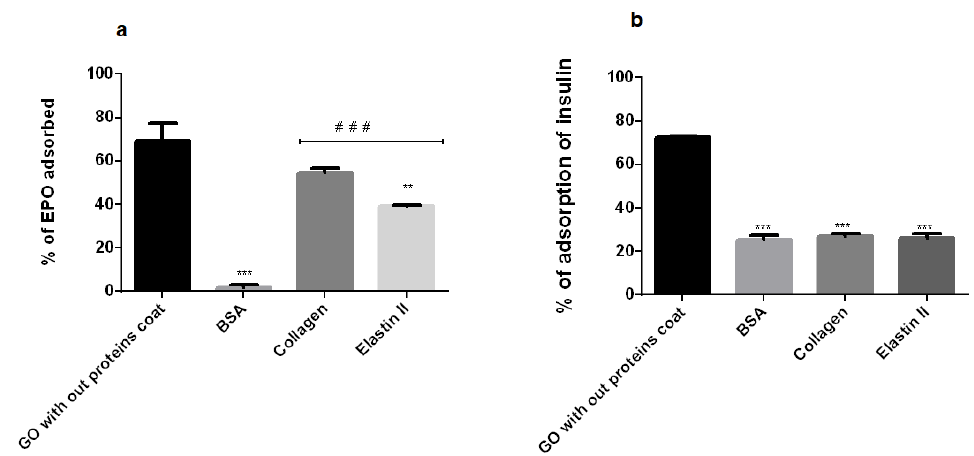
Figure 12. Percentage of ( a ) EPO and ( b ) insulin adsorbed by GO without coating, and BSA-, collagen- and elastin-coating. Incubation conditions: GO final concentration, 50 µ g / mL; temperature, 37 ◦ C; incubation time, 24 h. Note: p < 0.01; **: p < 0.001; *** compared with non-coated GO. ###: p < 0.001 compared to BSA